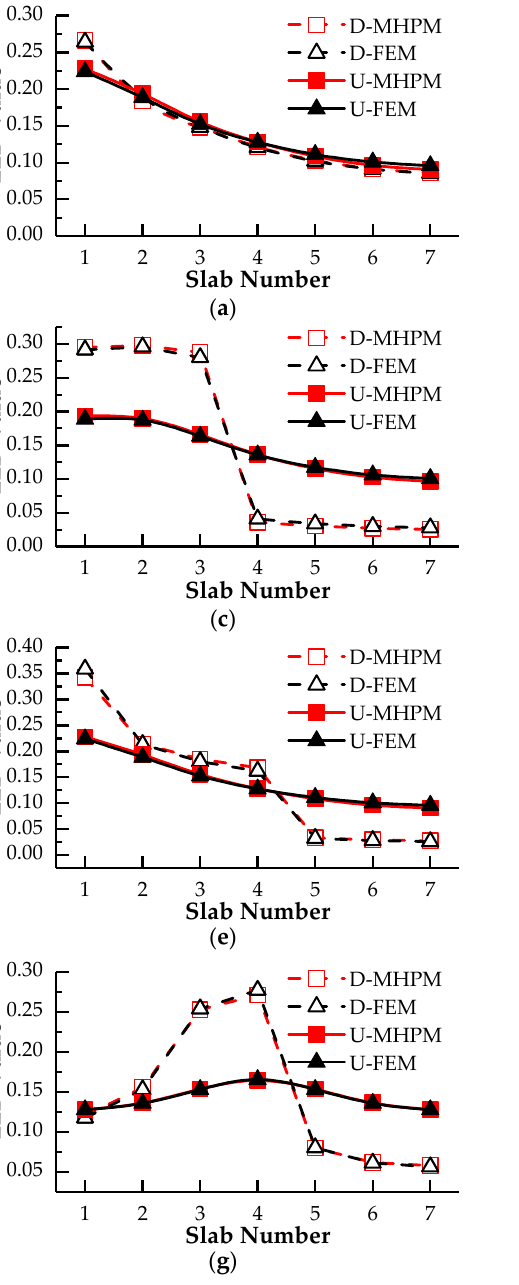
Figure 8. LLD influence lines under damage and intact cases of 7-slab bridge: ( a ) case 5: slab 1; ( b ) case 5: slab 4; ( c ) case 6: slab 2; ( d ) case 6: slab 5; ( e ) case 7: slab 1; ( f ) case 7: slab 3; ( g ) case 8: slab 4; ( h ) case 8: slab 7.